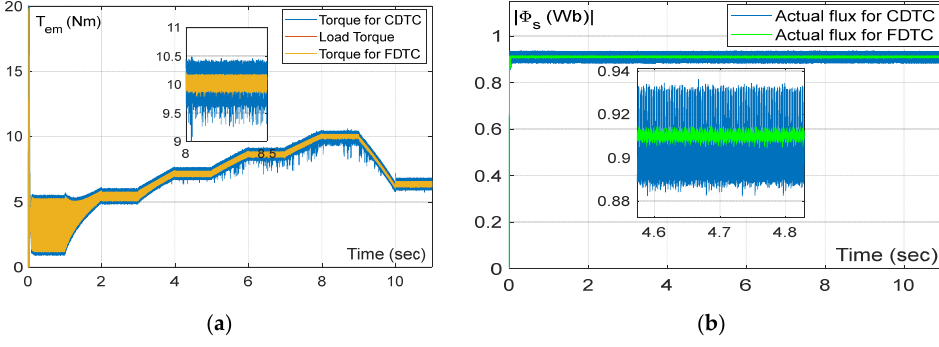
( b ) Figure 15. THD for stator phase current is: ( a ) conventional DTC and ( b ) fuzzy DTC.